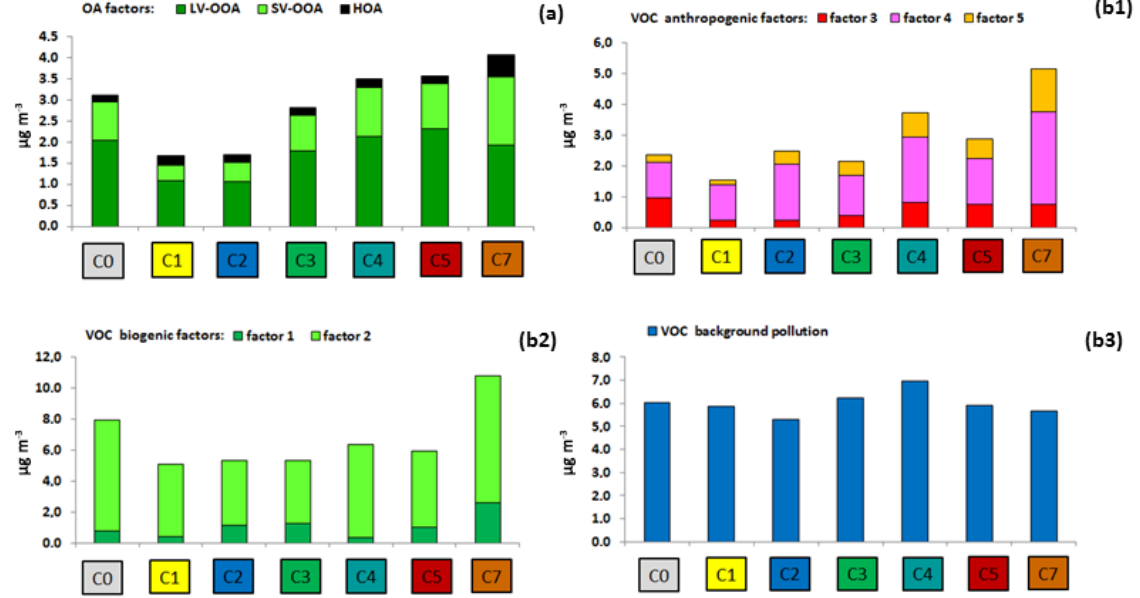
Figure 16. Accumulated average contributions of the OA and VOC factors ( a and b , respectively) as a function of air mass origins. Clas- sification of air masses: C0 – local; C1 – N. Africa; C2 – marine; C3 – Europe; C4 – northwest. Asia; C5 – the west of Turkey and C7 – southwest Asia. VOC factors: factor 1 – biogenic source 1; factor 2 – biogenic source 2; factor 3 – short-lived combustion source; factor